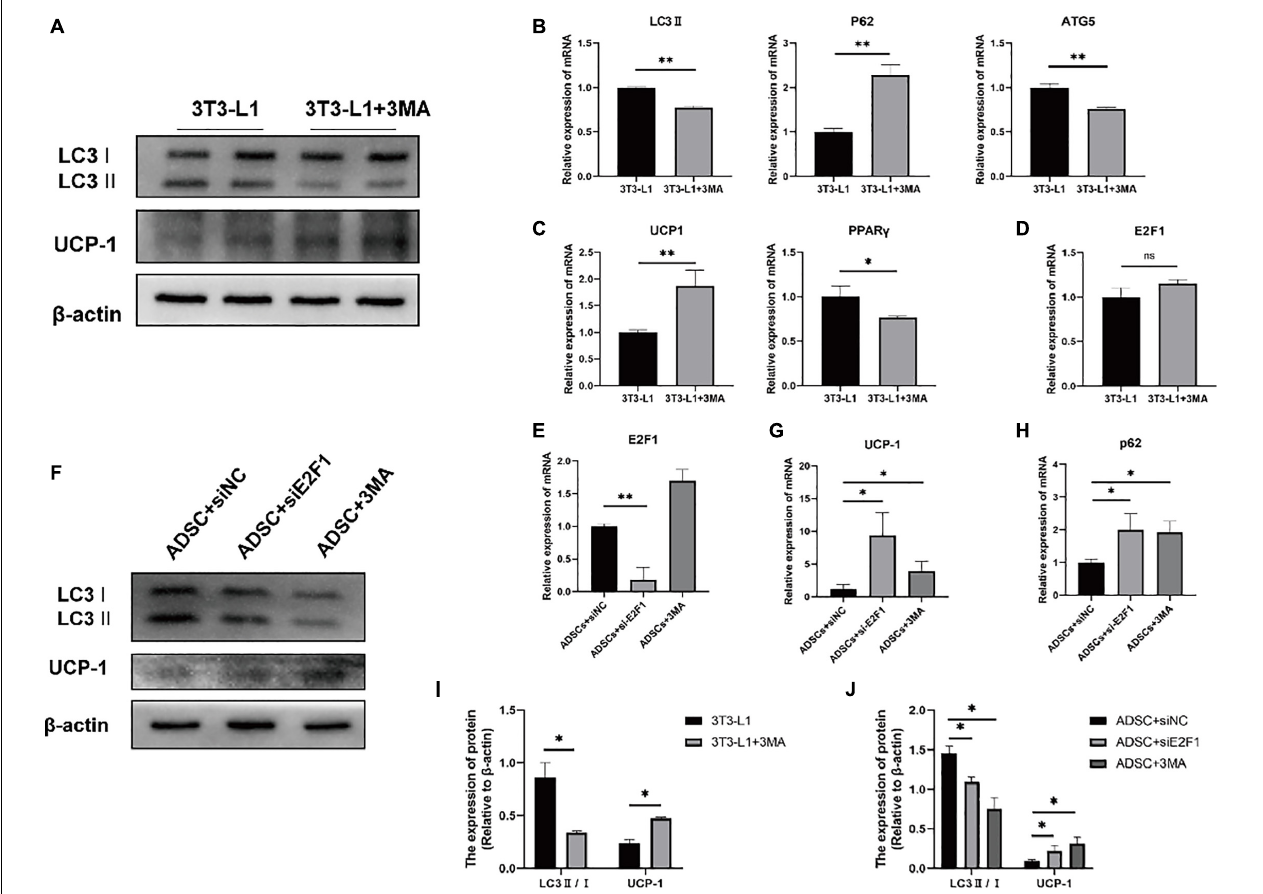
FIGURE 6 | Autophagy inhibition increased the UCP-1 expression, without reduced E2F1 expression in adipocytes in vitro . (A) Representative Western Blot image showing the level of LC3-II/I and UCP-1 protein in 3T3-L1 adipocytes and 3T3-L1 + 3MA adipocytes. (B–D) qRT-PCR analyses of LC3-II, p62, ATG5, UCP-1, PPAR γ , and E2F1 expression at the mRNA level in 3T3-L1 adipocytes and 3T3-L1 + 3MA adipocytes. (E) The qRT-PCR analysis of E2F1 expression at the mRNA level in ADSCs + siNC group, ADSCs + E2F1 siRNA group, and ADSCs + 3MA group. (F) Representative Western Blot image of LC3-II/I, and UCP-1 protein levels in ADSCs + siNC group, ADSCs + E2F1 siRNA group, and ADSCs + 3MA group. (G,H) The qRT-PCR analyses of p62, and UCP-1 expressions at the mRNA level in ADSCs + siNC group, ADSCs + E2F1 siRNA group, and ADSCs + 3MA group. (I) Quantitative analysis of the LC3-II/I and UCP-1 protein expressions relative to β -actin in 3T3-L1 adipocytes and 3T3-L1 + 3MA adipocytes, n = 3. (J) Quantitative analysis of the LC3-II/I and UCP-1 protein expressions relative to β -actin in ADSCs + siNC group, ADSCs + E2F1 siRNA group, and ADSCs + 3MA group, n = 3. ∗ P < 0.05, ∗∗ P <